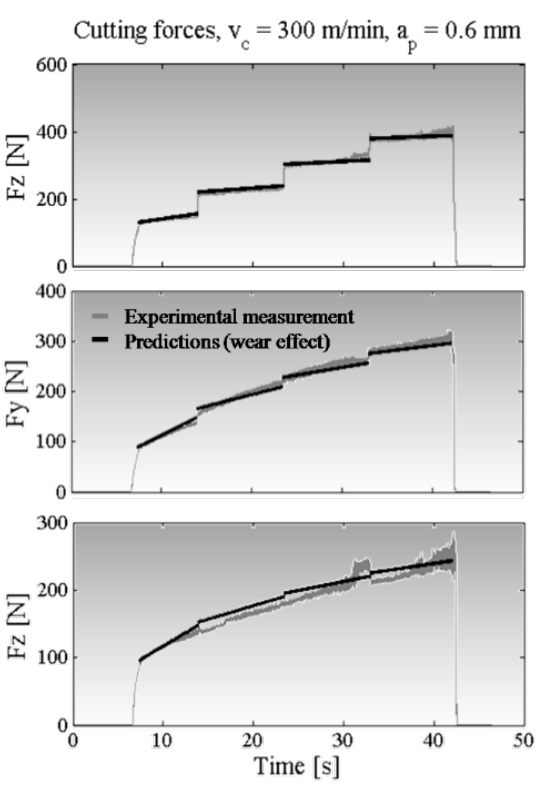
Figure 7: Force prediction considering the wear